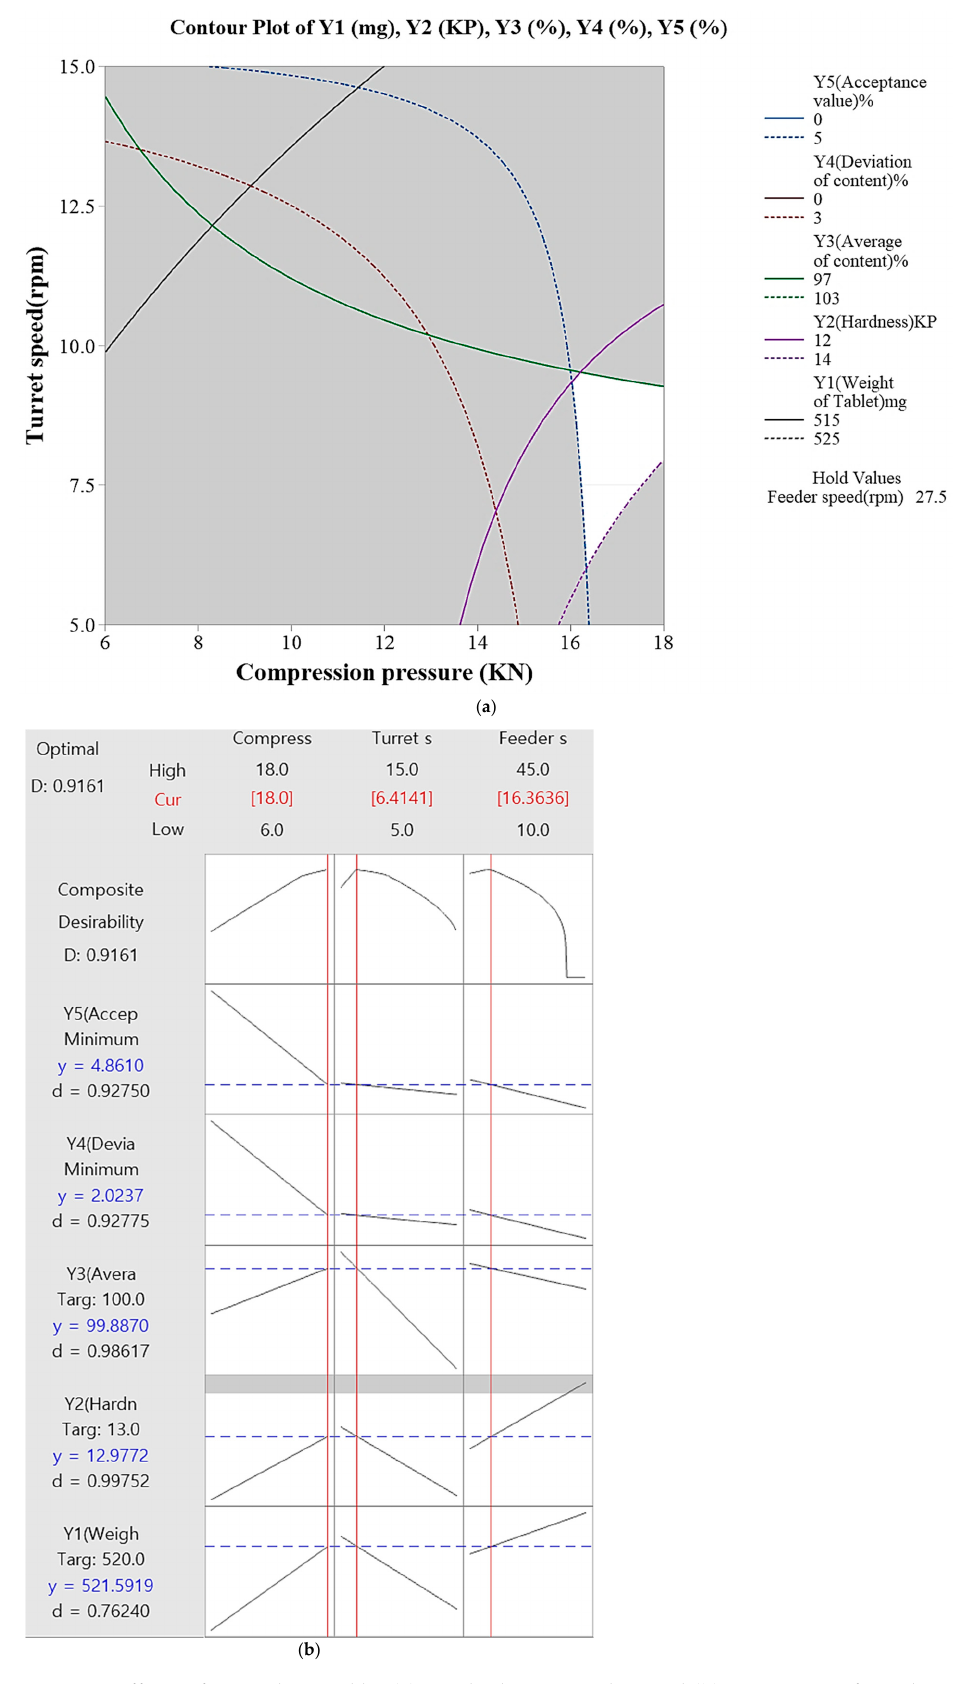
Figure 9. E ff ects of CPPs depicted by ( a ) overlaid contour plots and ( b ) response surface plots.